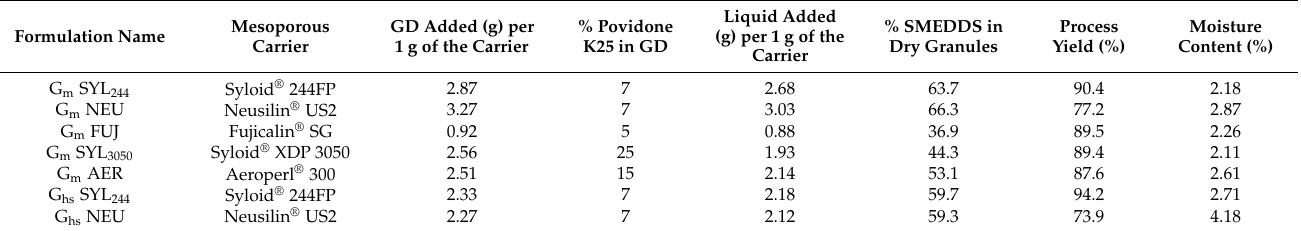
Table 2. Highest SMEDDS loading and composition of optimal SMEDDS formulations obtained from each mesoporous carrier by either manual (G m ) or high-shear granulation (G hs ); granulation dispersion (GD) consisted of various amount of povidone K25 (binder) dissolved in liquid phase composed of 70% SMEDDS and 30%